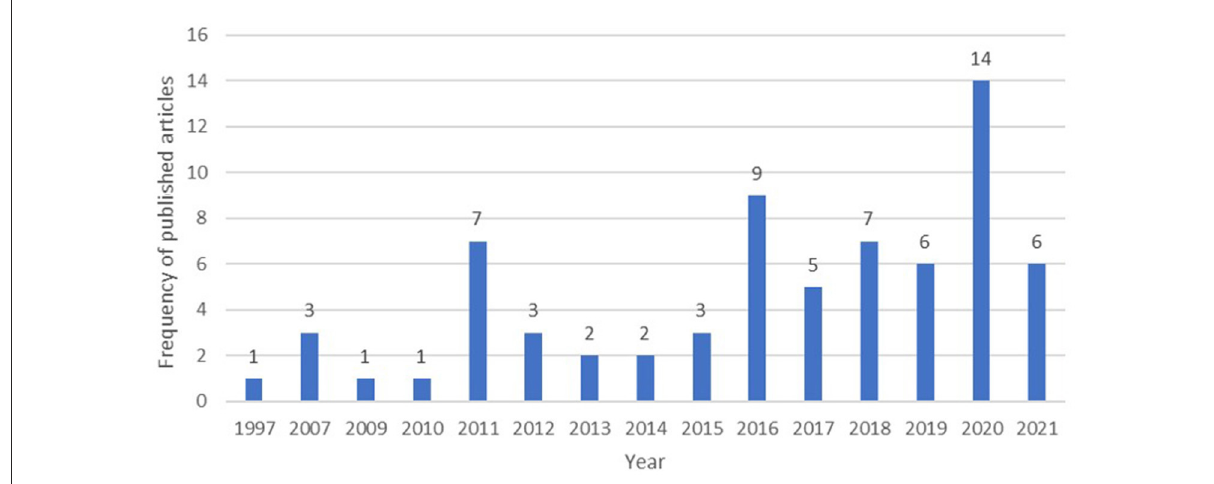
FIGURE1 Number of published articles included in this review per